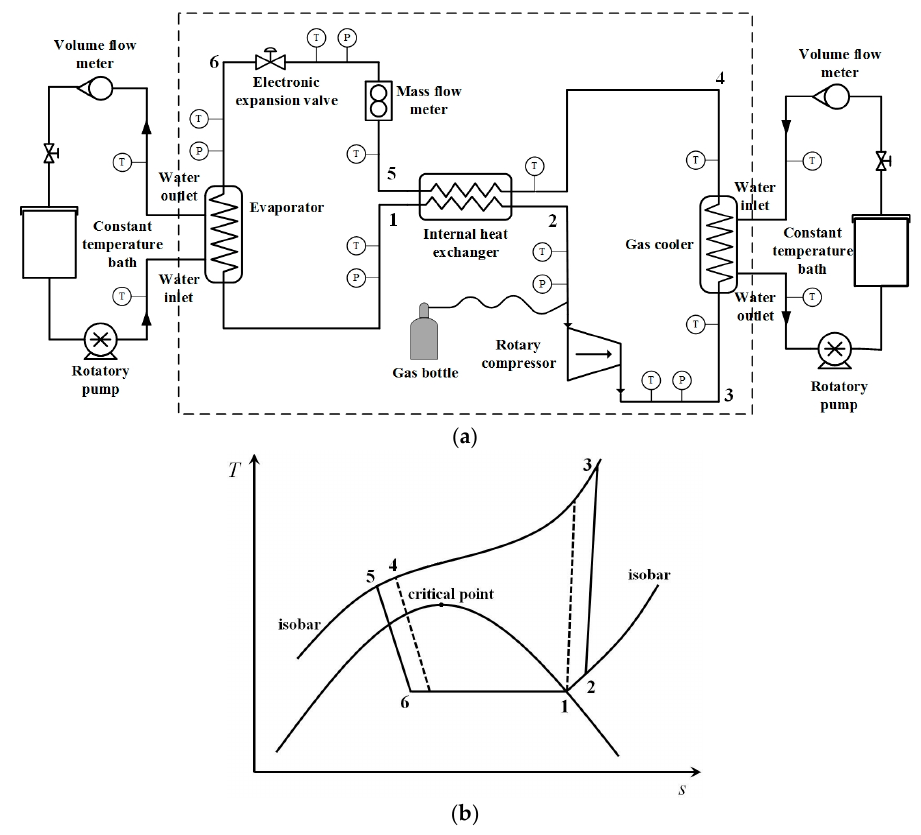
Figure 1. Schematic diagram of the experimental setup: ( a ) Schematic diagram, ( b ) T-s